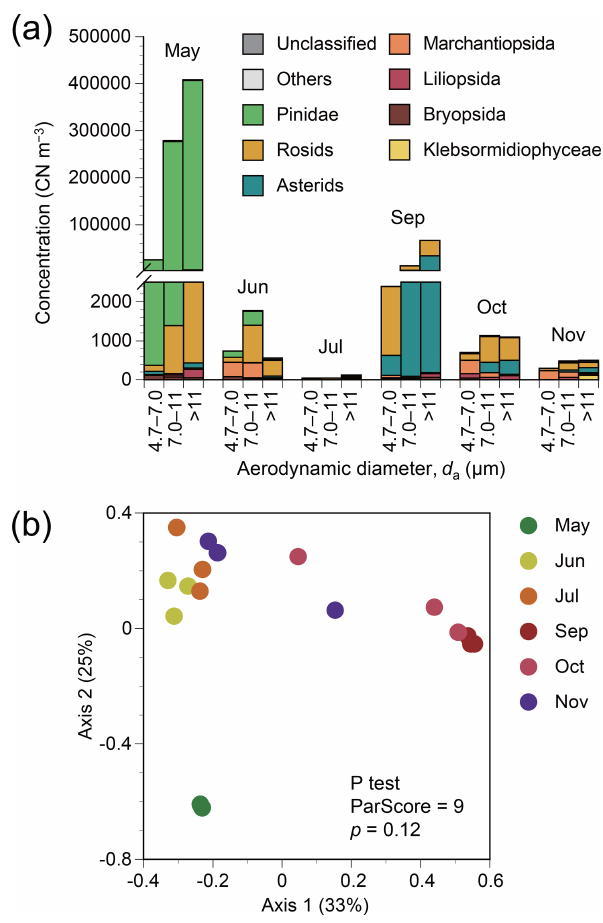
Figure 1. (a) Particle size-resolved concentrations based on plant classes or clades in terms of copy number (CN) of ITS2 from at- mospheric samples from Seoul in South Korea. Monthly results from May to November 2015 are shown, except for August when air sampling failed. The data shown are obtained by multiplication of DNA sequencing-derived relative abundance of each family by a total plant concentration measured by the universal plant-specific qPCR assay. (b) Principal coordinate analysis plot for plant assem- blage structures based on Bray–Curtis distance. The data shown are based on DNA